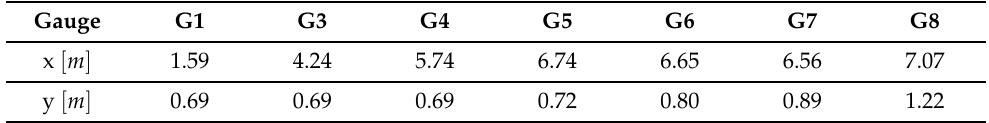
Table 6. Coordinates of the gauges G1–G8 of the CADAM test